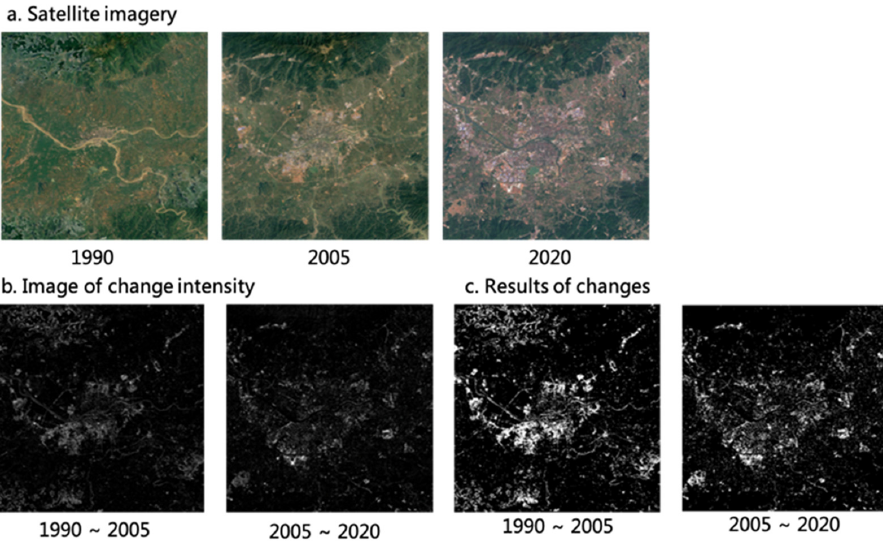
Figure 15. Comprehensive land cover change detection results.